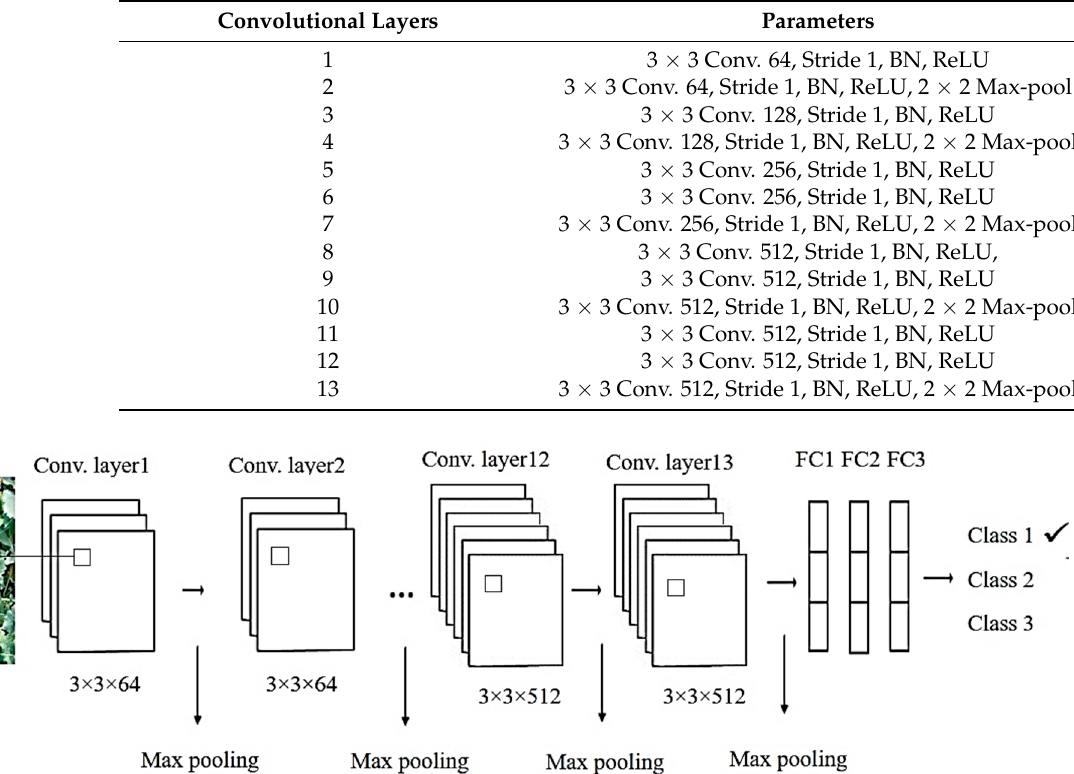
Table 2. Characteristics of Vgg16 to classify rapeseed crop in terms of health.